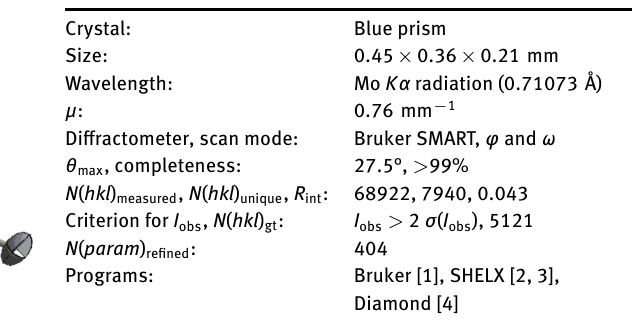
Table 1: Data collection and